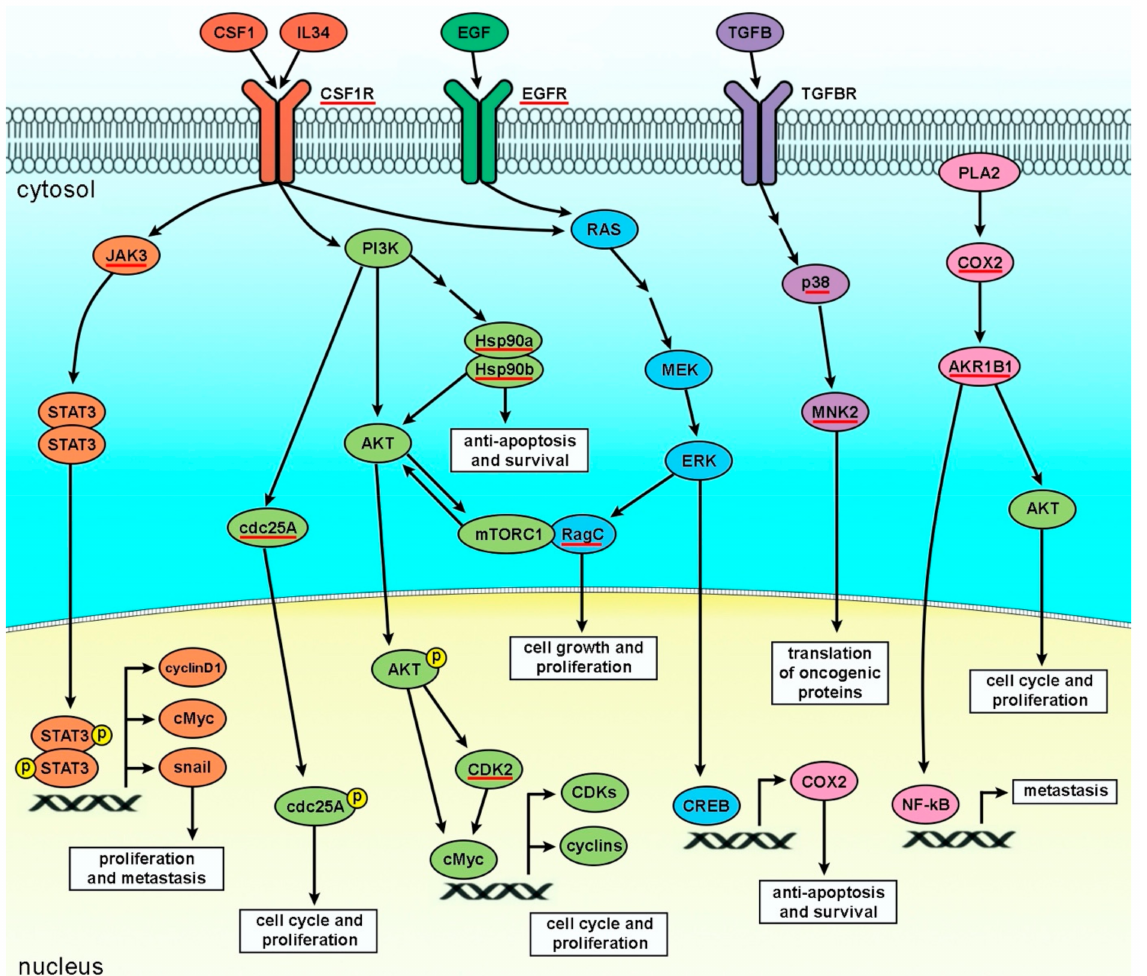
Figure 11. Top 12 candidate proteins of four kusunokinin isomers (red underlines) in the breast cancer progression pathway. Trans -( )-kusunokinin showed best binding to CSF1R while trans -(+)- − kusunokinin and the two cis -isomers possibly targeted